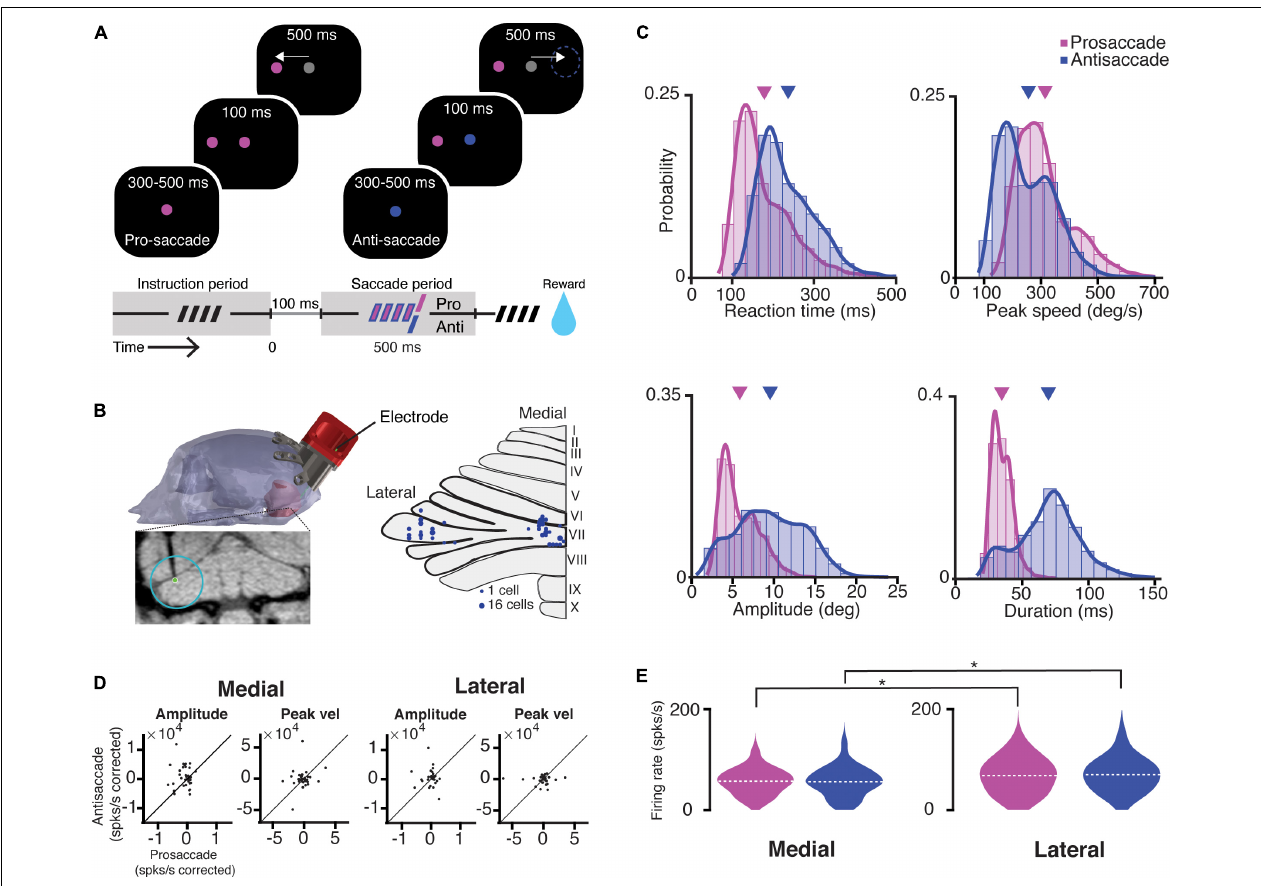
FIGURE 1 | Task, recording location, saccade kinematics, and related PC firing characteristics. (A) A scheme representing the different periods of the task. The trial condition was indicated by the color of the fixation point. After a random delay between 300 and 500 ms (i.e., instruction period, dashed symbol), a target appeared in one of the eight locations, while NHPs were required to maintain the fixation for 100 ms. Next, the fixation target switched to gray, and the NHPs were given 500 ms to execute a saccade (i.e., saccade period) toward the target (prosaccade) or the mirror position of the target (antisaccade). (B) Left, MRI-based 3D-reconstruction of the skull of Mi; bottom, coronal MRI section showing the localization of an electrode in the left lateral cerebellum; right, an overview of the localization of recording sites in the medial (vermal lobules VIc and VII) and lateral cerebellum (crus-I/II, left hemisphere). (C) Features of kinematics of all prosaccades (magenta; monkey Mo n = 6114, monkey Mi n = 6670) and antisaccades (blue; Mo n = 4114, Mi n = 6305) for all trials over the 122 recording sessions. Antisaccades were characterized by longer reaction times (pro- mean 178.4 ms ± 70.6 SD; anti- mean 236.6 ms ± 72.7 SD; p < 0.0001), lower peak velocities (pro- mean 311.8 ◦ /s ± 102.6 SD; anti- mean 253.4 ◦ /s ± 103.1 SD; p < 0.0001), bigger amplitudes (pro- mean 5.8 ◦ ± 2.3 SD; anti- mean 9.5 ◦ ± 4.1 SD; p < 0.0001), and longer durations (pro- mean 34.7 ms ± 7.9 SD; anti- mean 69.8 ms ± 24 SD; p < 0.0001). Triangles in magenta and purple indicate means of pro- and anti-saccade movement parameters, respectively. (D) Scatter plots with corrected PC activity after a linear regression model fitted to an amplitude or a peak speed during all pro- and antisaccades in the medial (left) and lateral (right) cerebellum. (E) Violin plots showing the mean average simple spike firing rates for all the cells during prosaccades (magenta) and antisaccades (blue) for the medial (left) and lateral (right) cerebellum). Dashed lines depict the mean value of the population. The asterisks show significance levels for a Wilcoxon rank-sum test for the comparison between the medial and lateral cerebellum in each condition (pro medial vs. lateral p = 0.04; anti medial vs. lateral p =